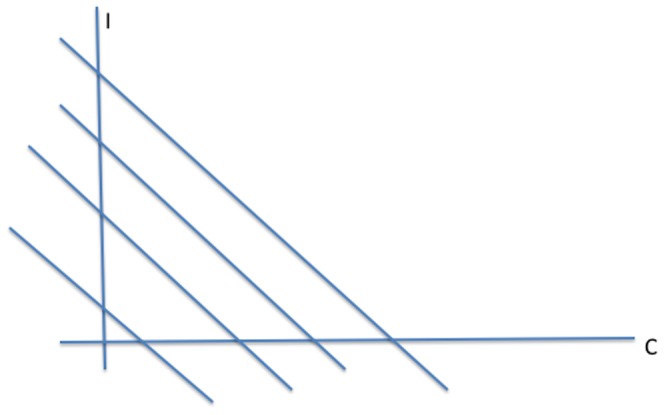
Levels sets of V.